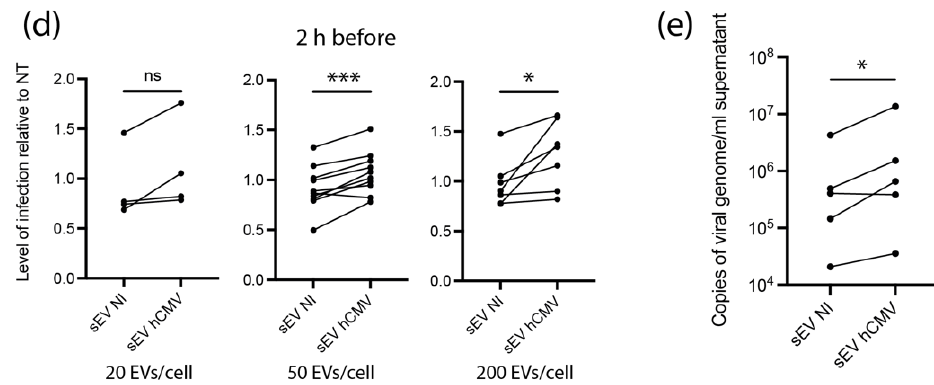
Figure 4. Effect of HIPEC sEVs on MRC5 cell permissiveness for hCMV. ( a ) Experimental procedure (NT = non-treated). ( b ) Immunofluorescence performed on MRC5 cells against IE viral antigen (blue: DAPI; red: IE1/2). Panel a- Non-infected control MRC5 cells upon 24 h incubation with sEVs isolated from hCMV-infected HIPECs. Panels b,c,d- MRC5 cells were either non-treated (Panel b- NT) or incubated during 2 h with sEVs prepared from non-infected (Panel c- sEV NI) or infected HIPECs (Panel d- sEV hCMV) with 50 sEV per cell, then infected during 24 h with hCMV at a MOI of 0.5 before proceeding to immunofluorescence. Scale bar: 200 μ m. ( c , d ) MRC5 cells were incubated with sEVs prepared from non-infected (sEV NI) or hCMV-infected (sEV hCMV) HIPECs and infected by hCMV at a MOI of 0.5, concomitantly ( c ) or 2 h after sEV incubation ( d ). Three increasing doses of sEVs were used in these experiments (20, 50, or 200 sEV per MRC5 cell, from left to right). Then, 24 h later, expression of IE antigen was assessed by immunofluorescence. percentage of cells infected by hCMV without any sEV (NT). Each dot is an independent experiment and corresponds to the mean of the counting of 10 fields, with around 70 cells counted, i.e., around 700 cells per dot. n = 4 to 10 independent experiments. Since sEVs used in infection assays were prepared each time in parallel between non-infected and hCMV-infected HIPECs from a given batch, statistical analysis was done by pairing the results between sEV NI and sEV hCMV for each